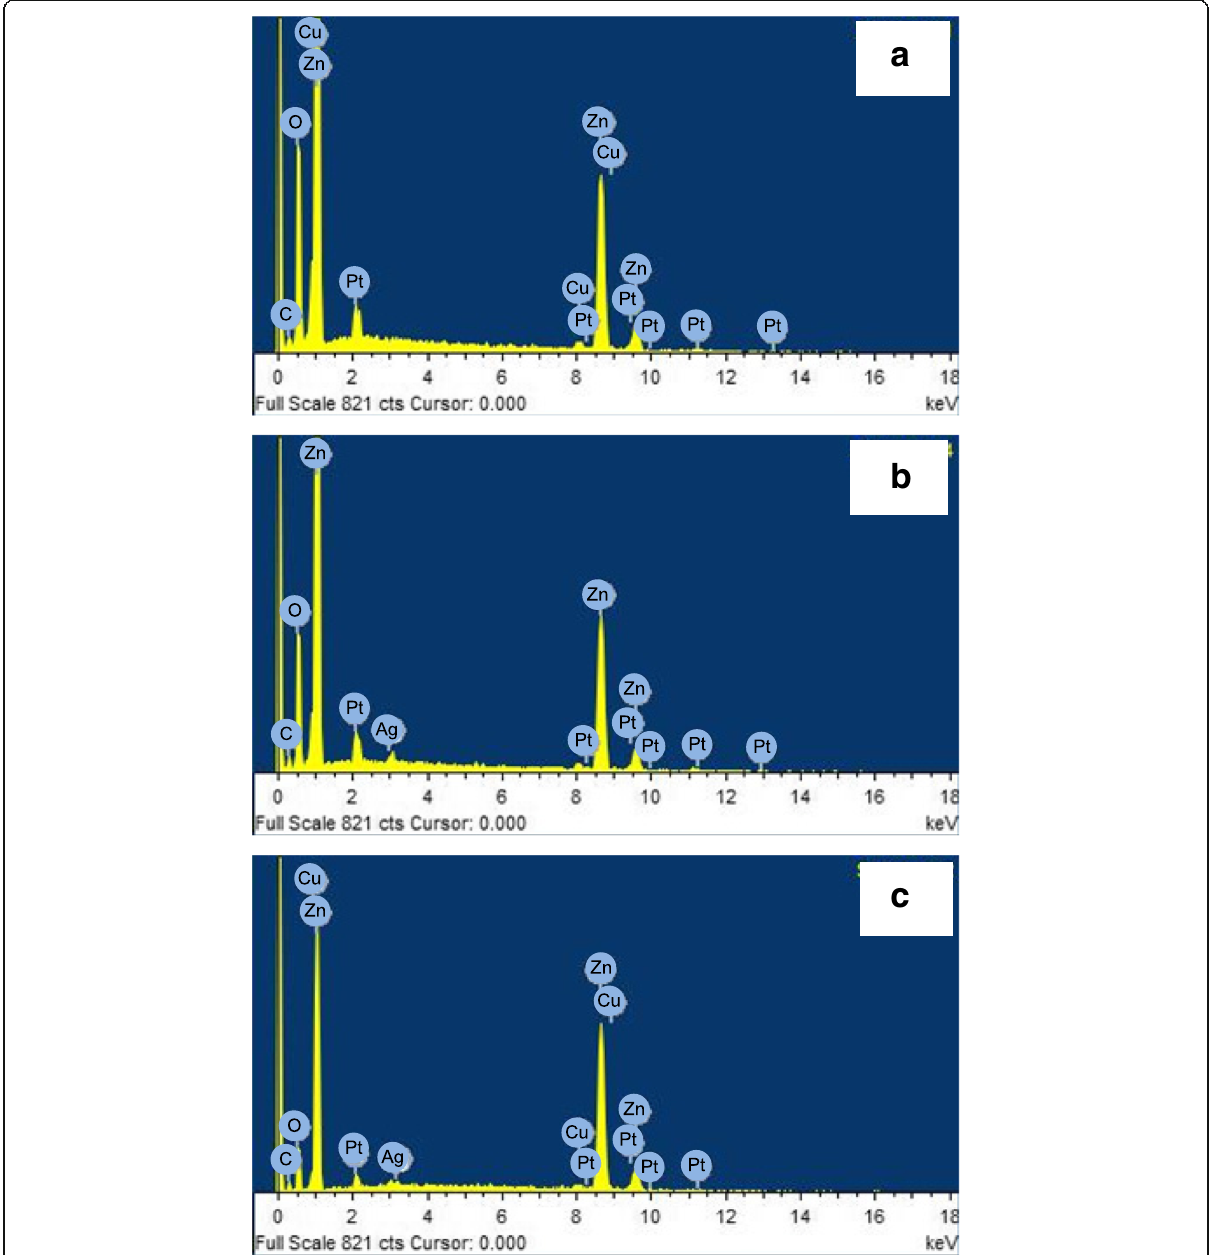
Fig. 2 a – c EDS spectra of the Cu 2 O/ZnO, Ag/ZnO, and Ag/Cu 2 O/ZnO NRs,